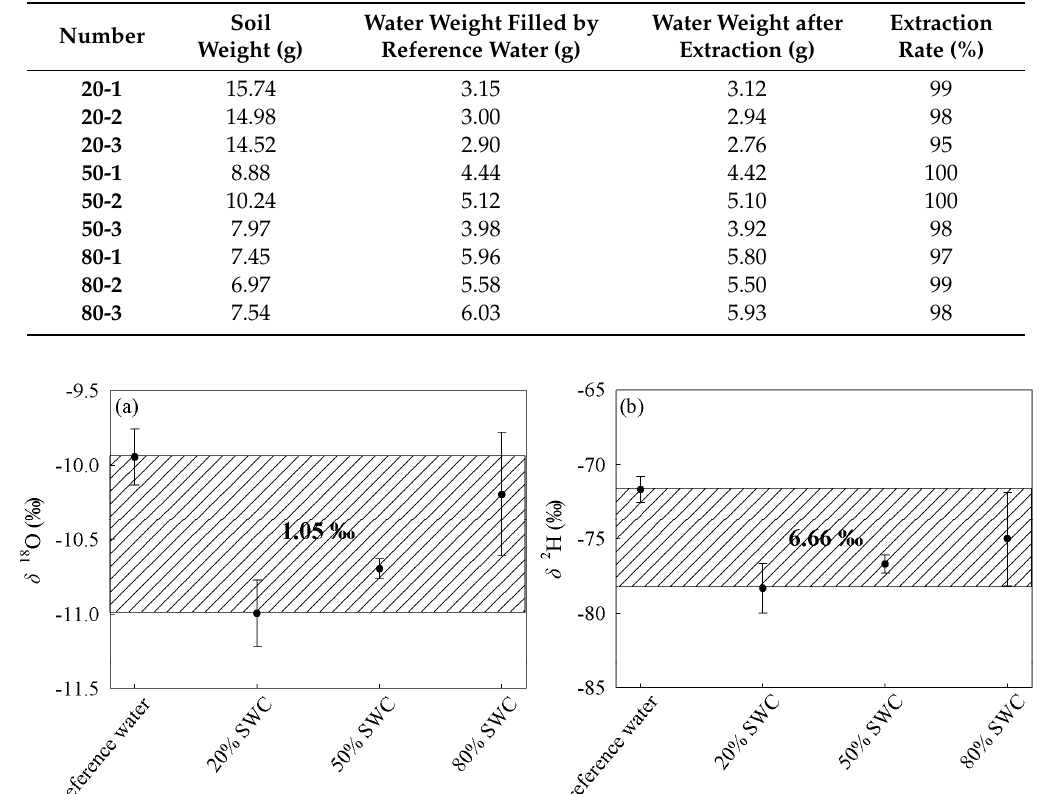
Figure 13. The isotopic differences for the soil samples with different SWC and the reference water. ( a ) and ( b ) are for δ 18 O and δ 2 H, respectively.